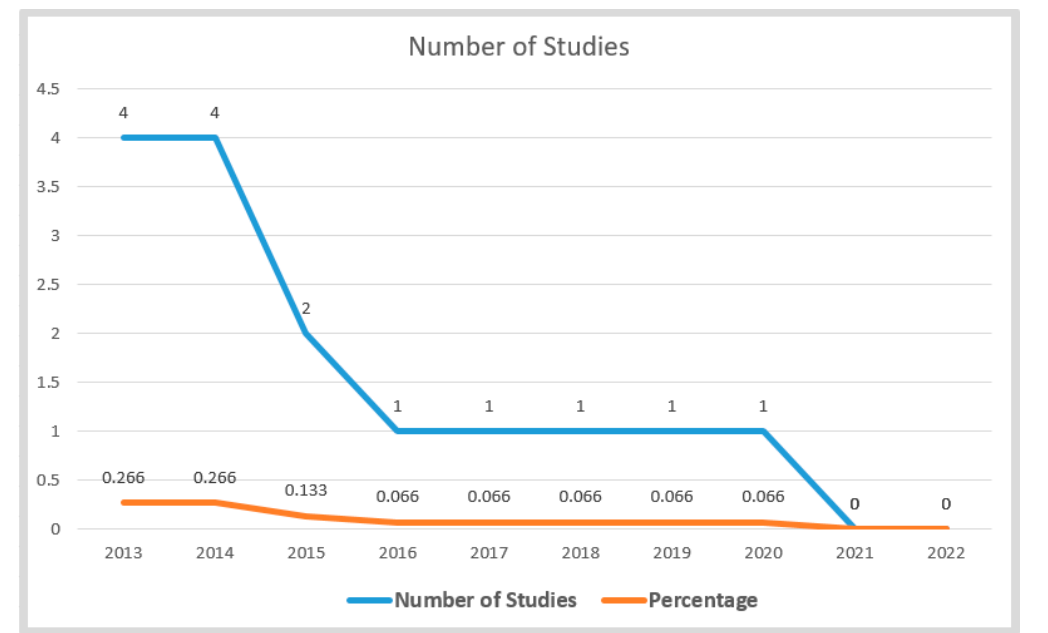
Figure 5. Distribution of BDMM studies by publication (2013–2022) year.